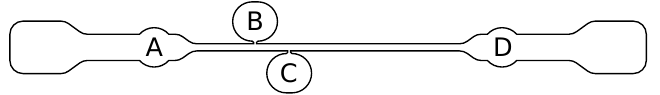
Figure 2. Pressure taps A, B, C and D location along the microchannel.